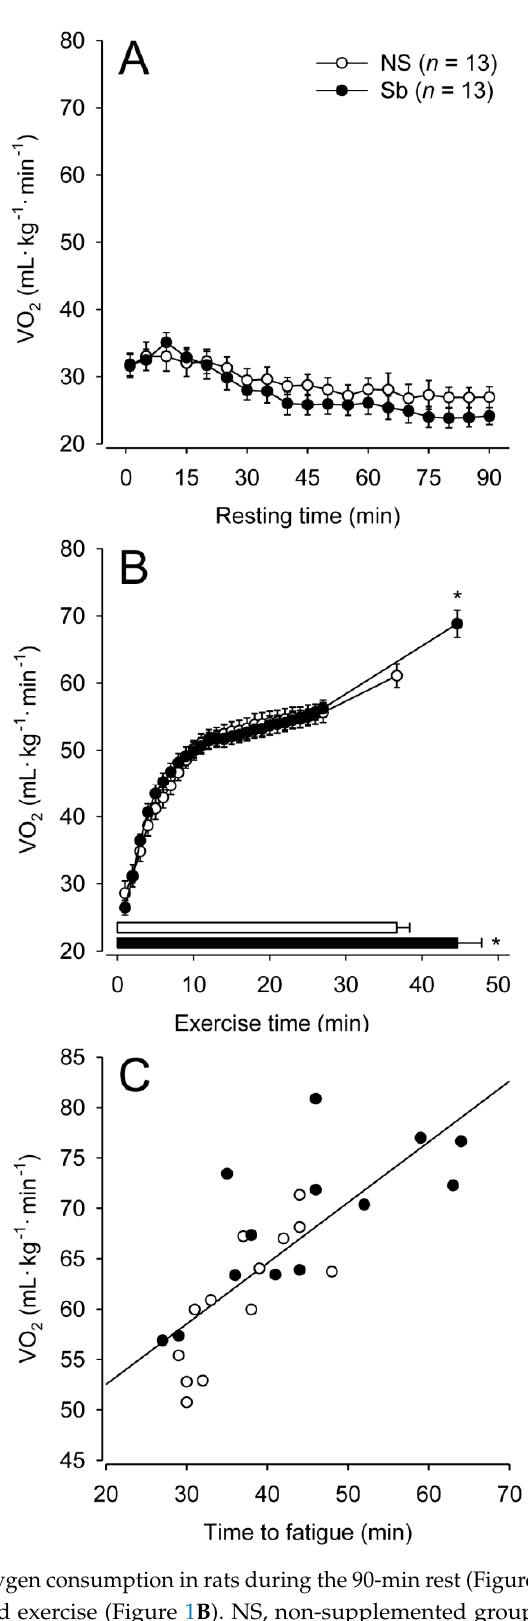
Figure 1. The rate of oxygen consumption in rats during the 90-min rest (Figure 1 A ) or in rats subjected to an incremental-speed exercise (Figure 1 B ). NS, non-supplemented group ( ○ ); Sb, Saccharomyces boulardii -supplemented group ( ● ). Data are expressed as the means ± SEM. The horizontal bars at the bottom of panel B represent the time to fatigue. * denotes a significant difference compared with the NS group. Figure 1 C shows the significant and positive correlation between the maximal rate of oxygen consumption (VO 2MAX ) and time to fatigue. Data are expressed as individual values.